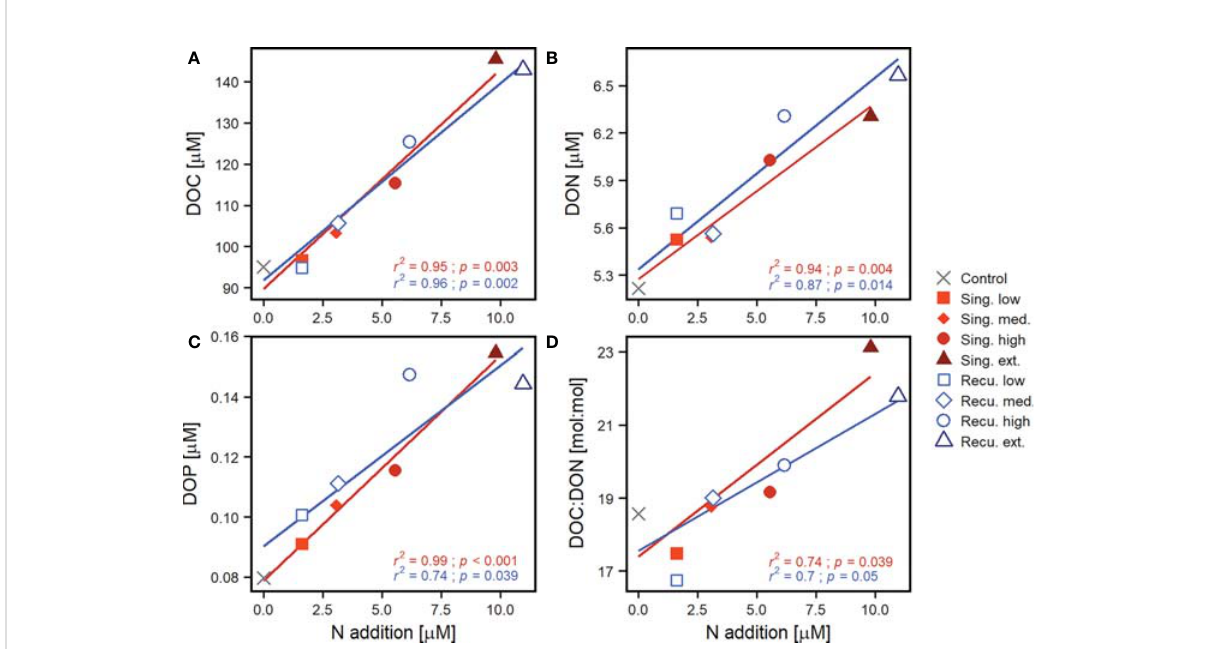
FIGURE 3 Effect of upwelling intensity on dissolved organic matter. Shown are linear regressions of (A) DOC, (B) DON, (C) DOP and (D) DOC : DON values against upwelling intensity (N addition) per upwelling mode. DOM values were averaged after the last deep water addition ( ≥ day 33). The coef fi cient of determination ( r 2 ) and p-value ( p ) of the regressions are included. Only the lines for signi fi cant regressions ( p < 0.05) are displayed (see Table S3 for detailed test statistics). Results for DOC : DOP and DON : DOP ratios can be found in Figure